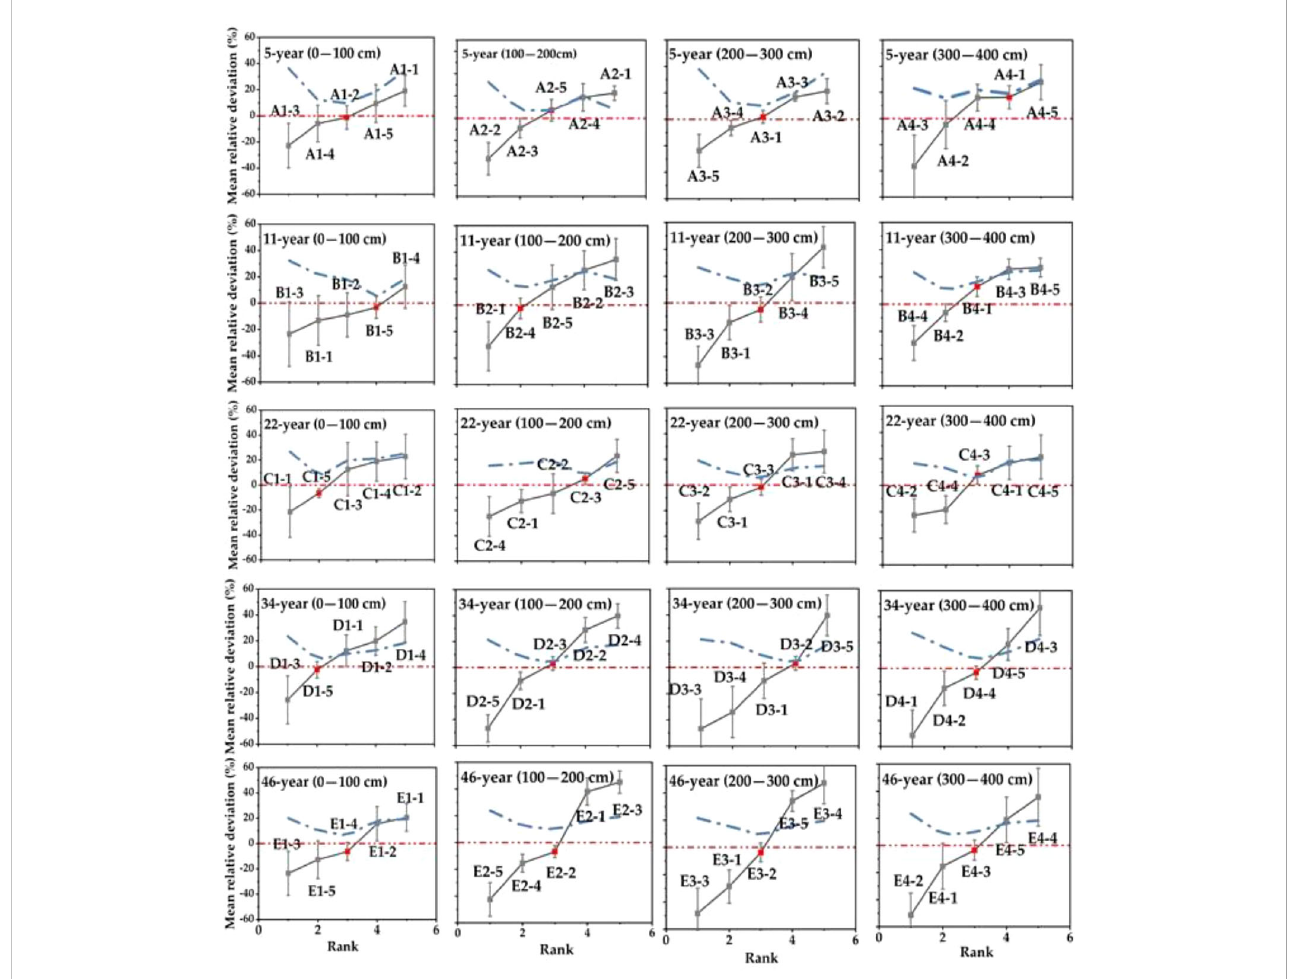
FIGURE 5 Ranked mean relative difference (MRD) of SWC in the diverse soil layers in HA plantations, the letters in the fi gure represent different stand ages: (A) 5- year-old, (B) 11-year-old, (C) 22-year-old, (D) 34-year-old and (E) 46-year-old. The numbers in the fi gure are the sample point numbers. The solid gray line indicates MRD, the red line is the baseline with an average relative deviation of 0. Error bars represent the standard deviation of relative difference (SDRD). The most time-stable locations are indicated by the red dots. The blue dotted line indicates index of temporal stability at